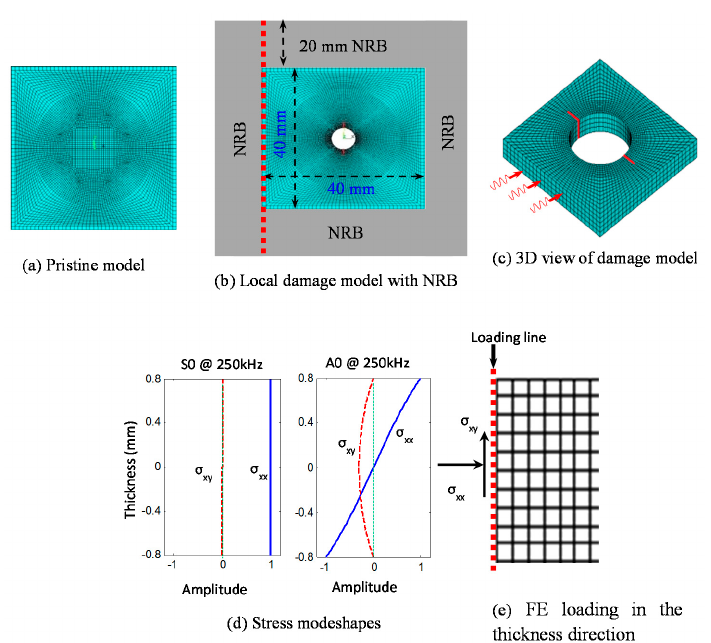
Figure 3. Illustration of local finite element method (FEM) modeling ( a ) Pristine model; ( b ) Local damage model with NRB; ( c ) 3D view of damage model; ( d ) Stress modeshapes; ( e ) FE Loading in the thickness direction.